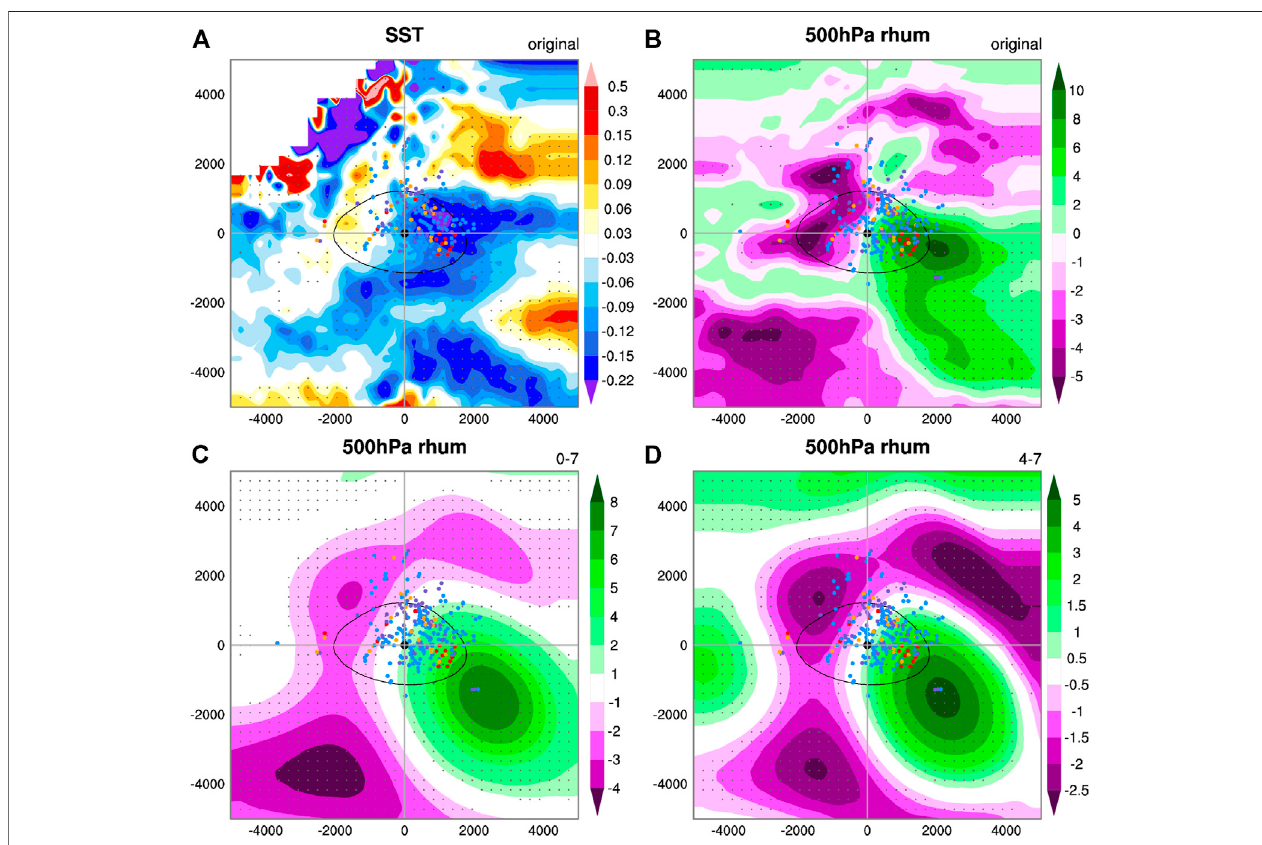
FIGURE 11 | (A) Composite SST anomalies ( ° C, shadings) relative to the daily climatology centered on the MG (B – D) Composite mid-level relative humidity anomalies (%, shadings) relative to the daily climatology centered on the MG (B) Relative humidity anomalies without spatial fi ltering (C) relative humidity anomalies with wavenumbers 0 – 7; and (D) relative humidity with wavenumbers 4 – 7. The origin (0,0) is the position of the MG center, and the large black dots is the MG and the small dots are the locations of the RW events. The black dots represent the area that exceeds the statistical Student ’ s t test at the 0.05 signi fi cance